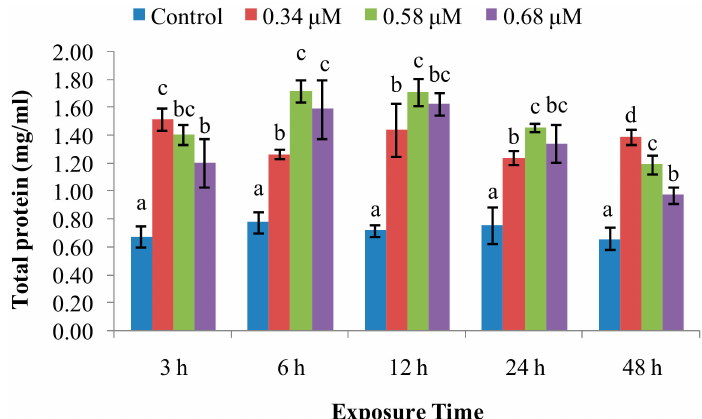
Figure 5. E ff ect of TD 49 on total protein levels in hemolymph at di ff erent time points after exposure to di ff erent concentrations (0, 0.34, 0.58, 0.68 µ M) of TD 49 . Data represent mean ± SD values ( n = 3) at the same time interval, with di ff erent letters denoting significant di ff erences ( p <